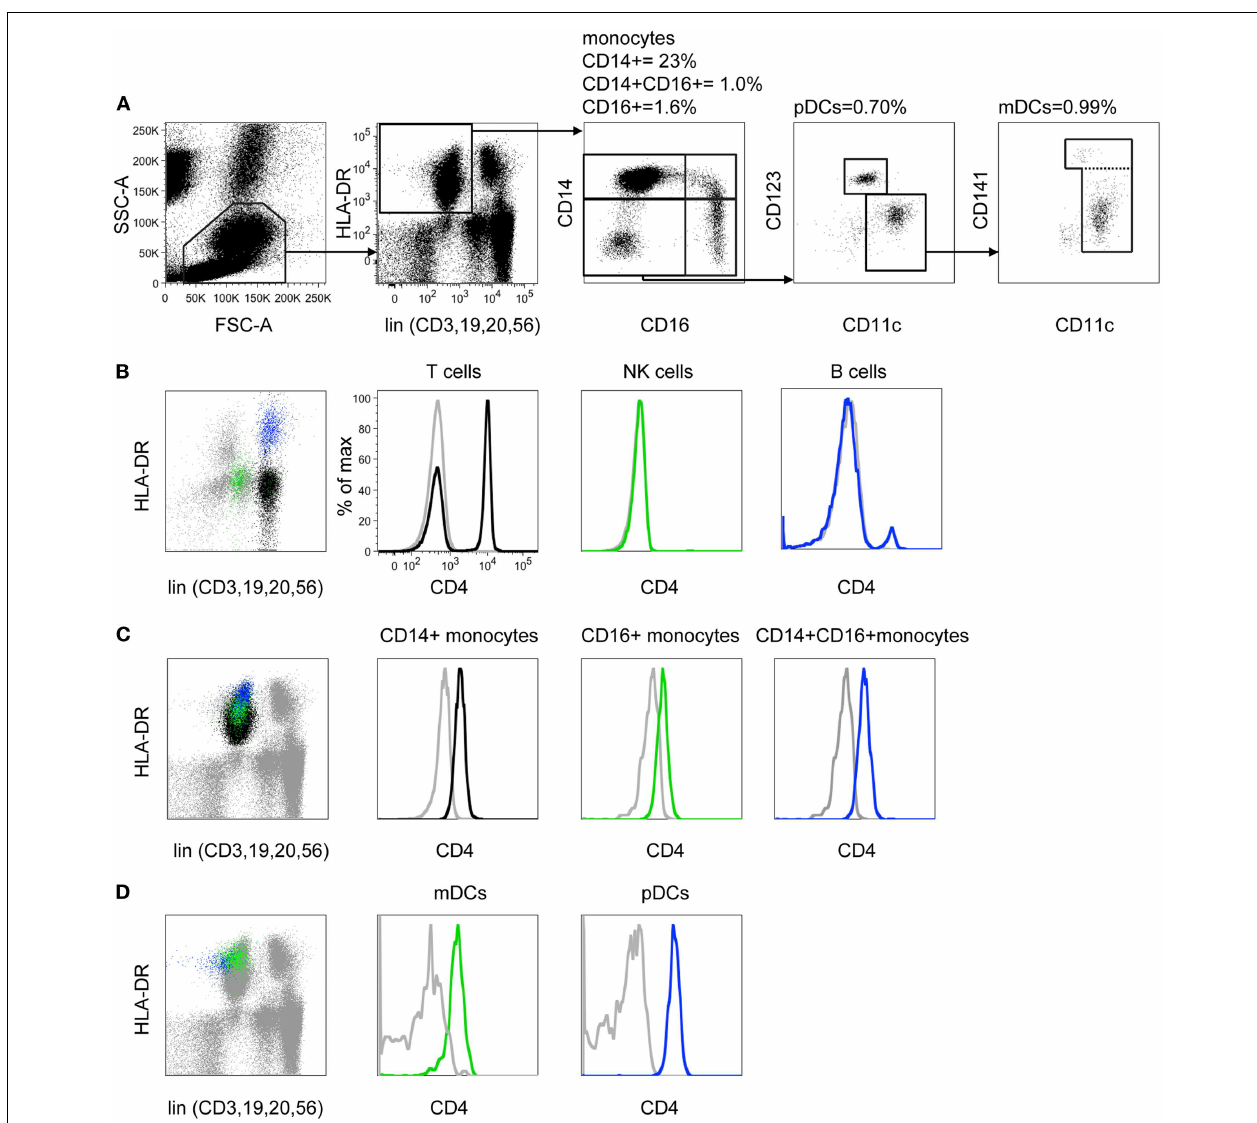
(green), and CD19 + B cells (blue) are back-gated onto the lineage vs. DR plot to demonstrate the locations of these populations. Expression of CD4 was then tested (colored histograms) relative to isotype control (gray). Note that a small population of activated DR + CD4 + T cells overlaps the B cell population. (C) CD14 + monocytes (black), CD16 + monocytes (green), and CD14 + 16 + monocytes (blue) are back-gated onto the lineage vs. DR plot. Expression of CD4 is shown (colored histograms), relative to isotype control (gray). (D) Myeloid DC (green) and plasmacytoid DC (blue) are back-gated onto the lineage vs. DR plot. Expression of CD4 is shown (colored histograms), relative to isotype